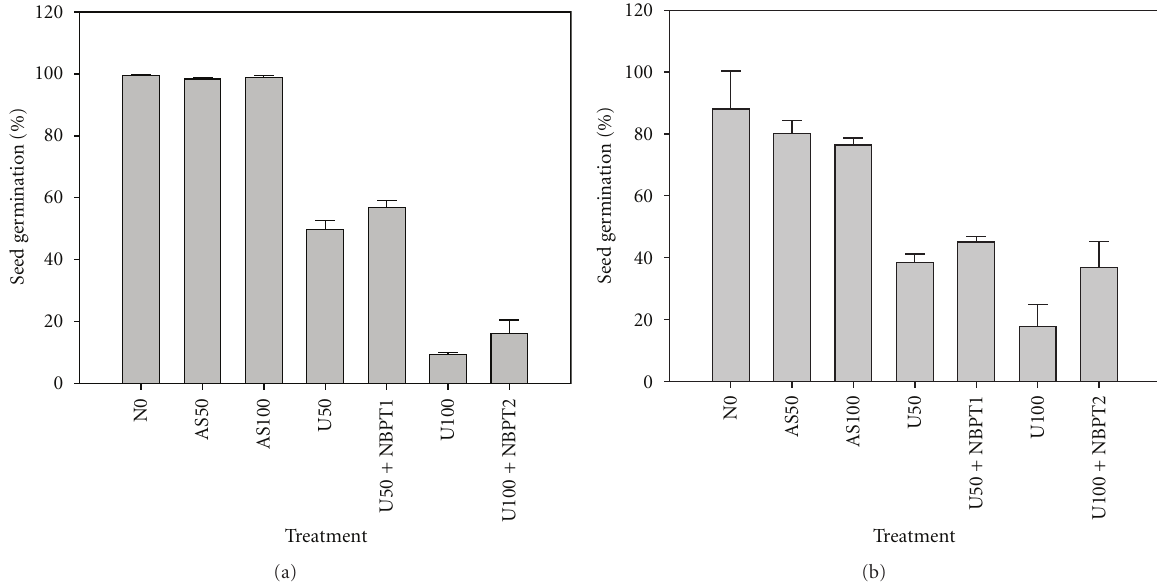
Figure 2: Seed germination percentage of Apo (a) and Hanyou3 (b) under application of AS50 (ammonium sulfate, 50kg Nha − 1 ), AS100 (ammonium sulfate, 100 kg Nha − 1 ), U50 (urea, 50kg Nha − 1 ), U100 (urea, 100kg Nha − 1 ), U50 + NBPT1 (50kgN ha − 1 + 1.09kg NBPTha − 1 ), and U100 + NBPT2 (100kg Nha − 1 + 2.18kg NBPTha − 1 ) in comparison with zero N input (control) in a field experiment. Error bars represent the standard